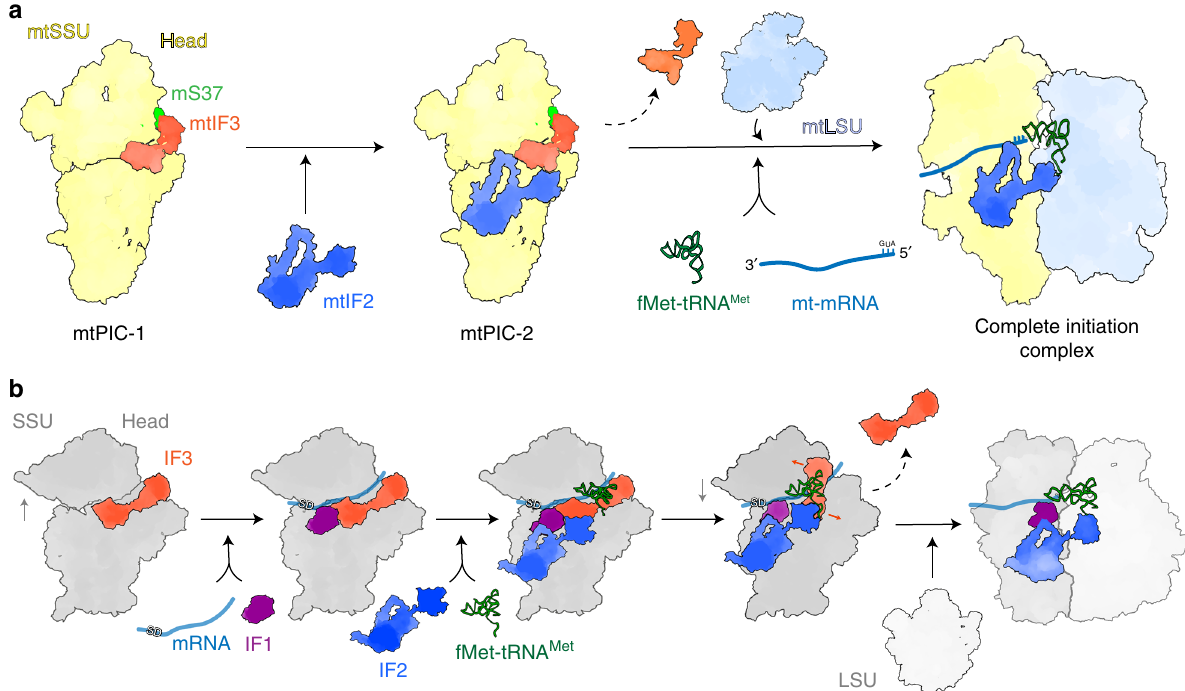
Fig. 7 Model of mitochondrial translation initiation and comparison with the bacterial system. a Translation initiation in mammalian mitochondria. The various structures are summarized in the order that represents a possible initiation pathway in which mtIF2 binding precedes mtLSU and tRNA binding. In this pathway, mtIF3 and mS37 stabilize the mtSSU head for the accommodation of mtIF2. Joining of the mtLSU may result in the conformational change of mtIF2 and GTPase activation that leads to tRNA and mRNA accommodation. Alternatively, transient binding of both mRNA and tRNA (not detected with our techniques) to the mtSSU after mtIF3 departure precede recruitment of the mtLSU. b Translation initiation in bacteria. Binding of canonical mRNA, fMet-tRNA Met i and initiator factors precede subunit joining and formation of the complete initiation